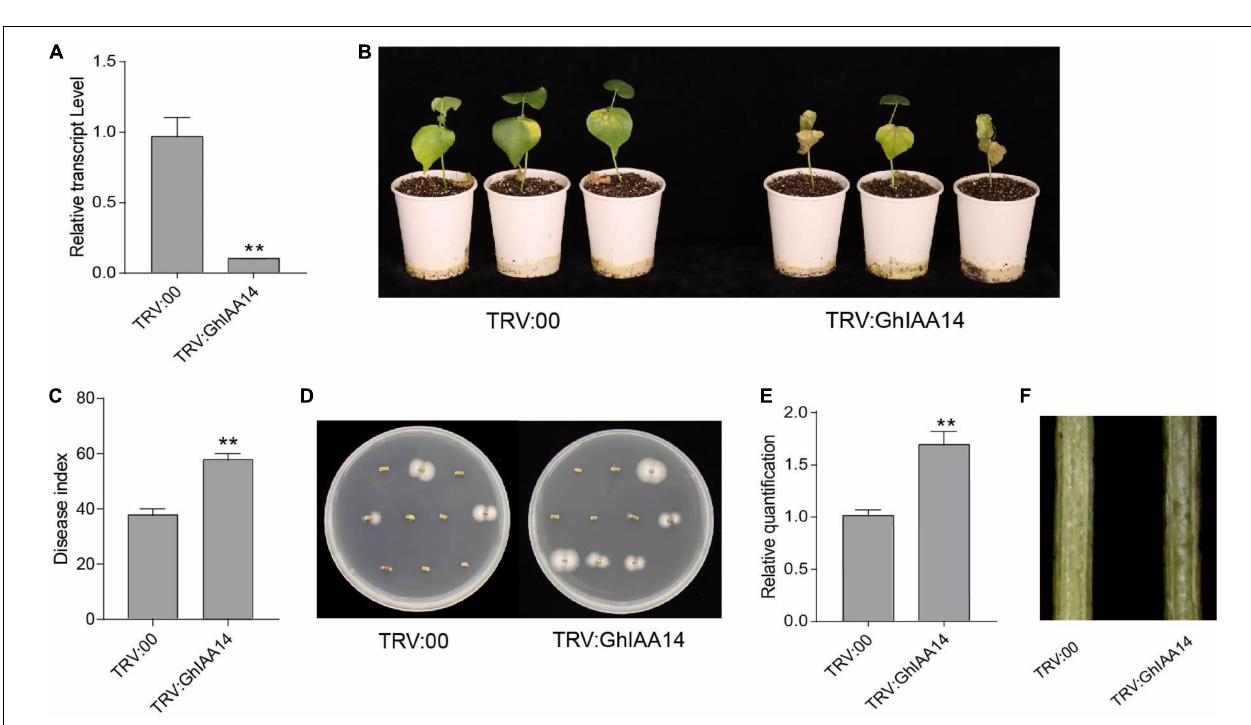
FIGURE 8 | Knockdown of GhIAA14 reduced plant resistance to Verticillium dahliae . (A) Relative expression of GhIAA14 in the TRV:GhIAA14 plants compared to TRV:00. (B) Disease symptom phenotypes of the TRV:GhIAA14 plants and the control at 21 dpi. (C) Disease index at 21 dpi. (D) Fungal recovery assay. (E) Relative V. dahliae fungal biomass in the infected stems. Statistical significance was determined by Student’s t -test: ** P < 0.01. The error bars represent the standard error of the mean of three biological replicates. (F) Longitudinal sections of cotton stems at 21 dpi.